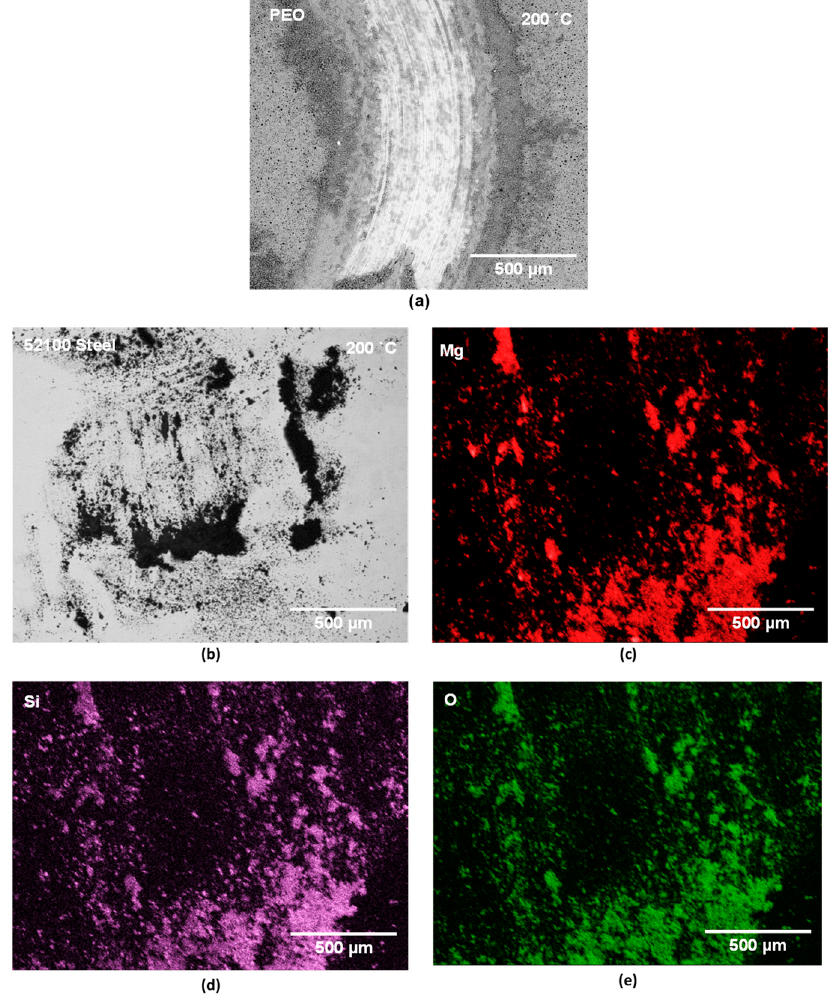
Figure 10. ( a ) Back scattered electron (BSE) image of the wear track formed on PEO when tested against steel ball at 200 ° C. ( b ) BSE image of the uncoated 52100 steel ball surface tested against PEO-coated AZ31 at 200 ° C. ( c – e ) The elemental EDS maps for ( c ) Mg, ( d ) Si, and ( e ) O.